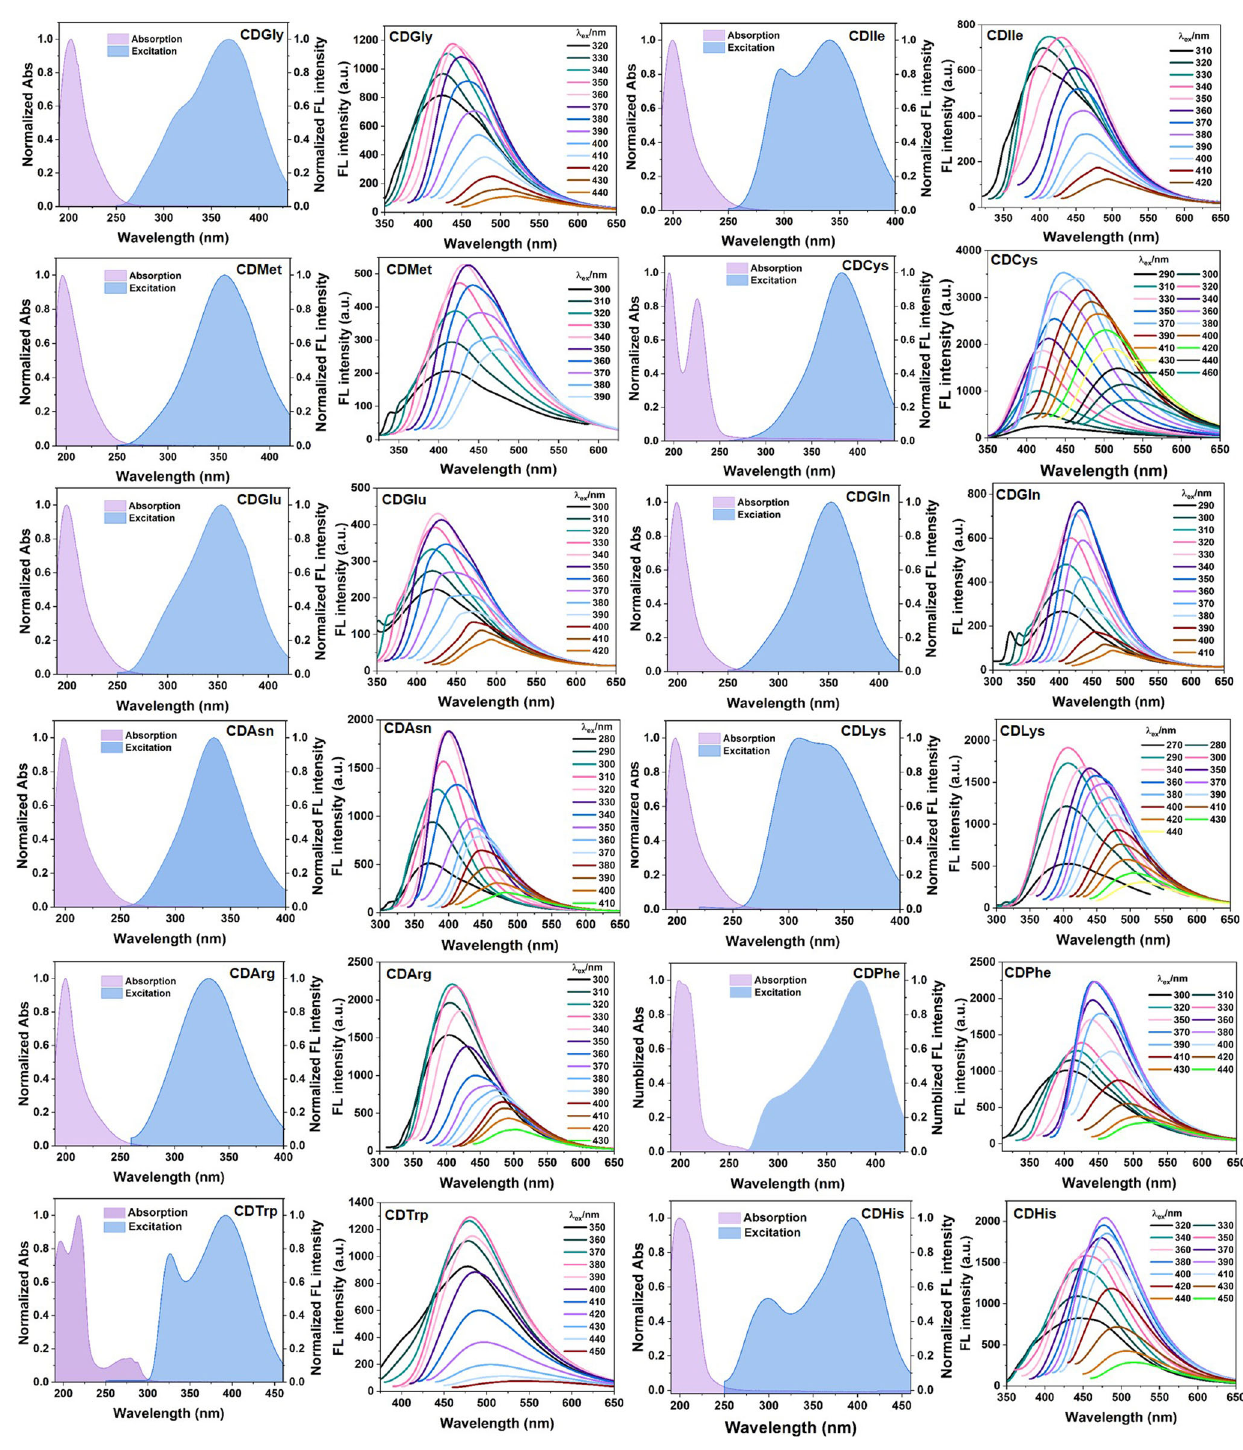
absorption spectra, excitation spectra, and fl uorescence spectra at different exci- tation wavelengths of CDAAs including CDGly, CDIle, CDMet, CDCys,